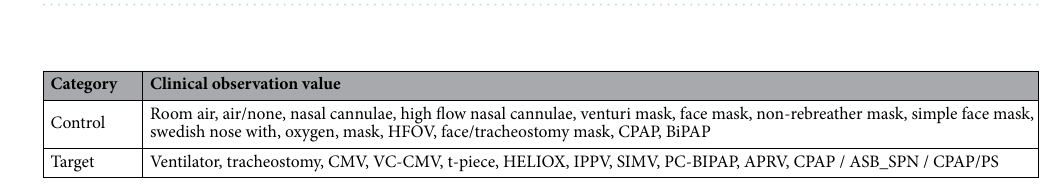
Table 2. Clinical endpoint cohorts.